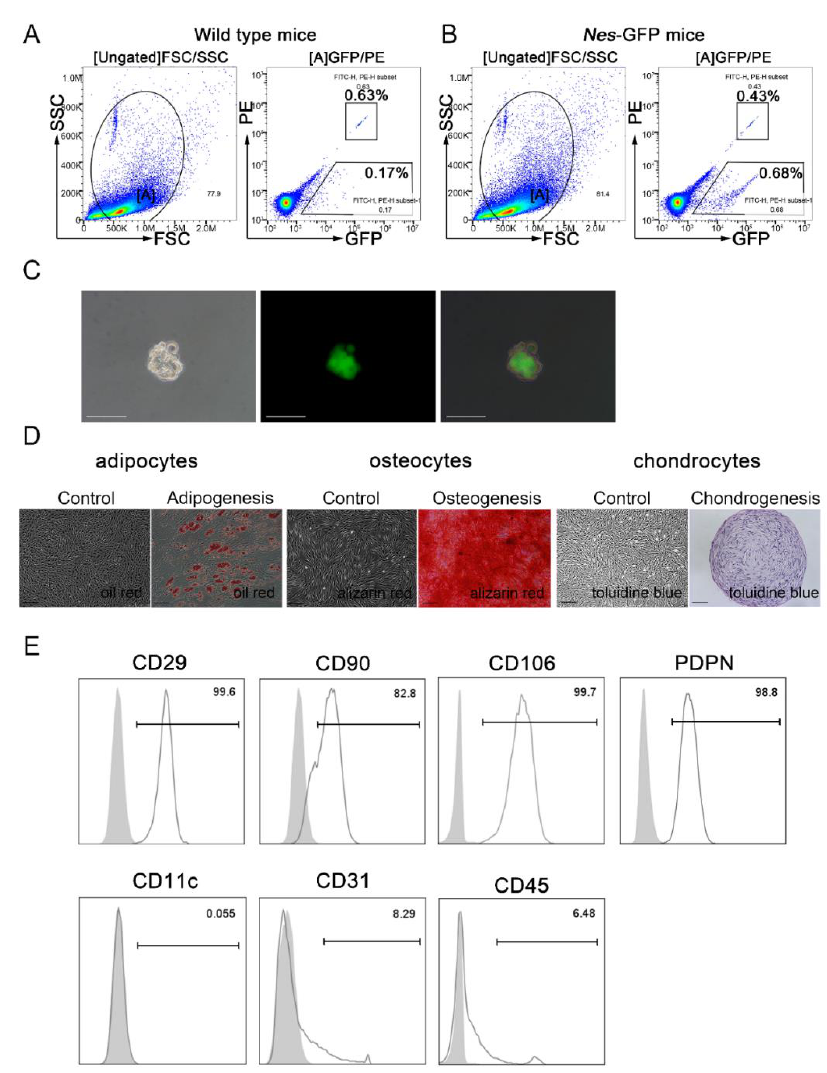
Figure 2. Isolation and characterization of Nes -GFP + cells from the spleen. ( A , B ) Flow cytometry was used to isolate Nes -GFP + cells from the spleens of Nes -GFP transgenic mice. Cells from wild-type C57BL/6 mice were isolated as a control. To detect the percentage and number of Nes -GFP + cells in cell sorting more precisely, we added the counting beads (both positive in PE and GFP channel) in the cell suspension of the spleen. ( C ) Representative images showing the clonal sphere growth of single Nes -GFP + cells were observed using a bright field (left panel) or fluorescence (middle panel). Scale bars, 50 μm. ( D ) Representative stained images showing that mouse spleen-derived Nes -GFP + cells could differentiate into osteocytes (Alizarin red), adipocytes (Oil red O), and chondrocytes (toluidine blue). Scale bars, 100 μm. ( E ) The expression of cell surface markers on Nes -GFP + cells was detected by flow cytometry.